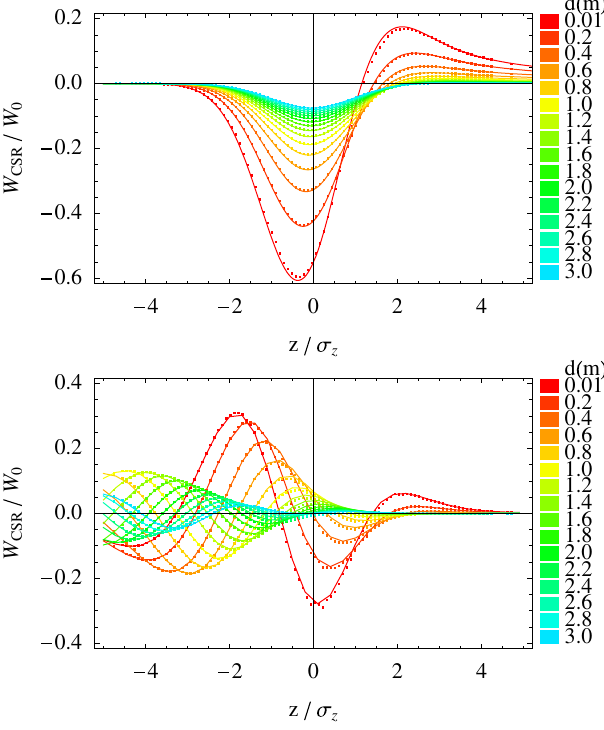
FIG. 16. (Color) Exit wakefield as a function of the length d from the end of the magnet for free space (top) and with shielding (bottom). Bmad (dots) shows excellent agreement with CSR-wake formula Eq. (48) (top lines) in the free space case, and with numerical integration over image bunches using Eq. ((47) (bottom lines). Parameters set A is used.